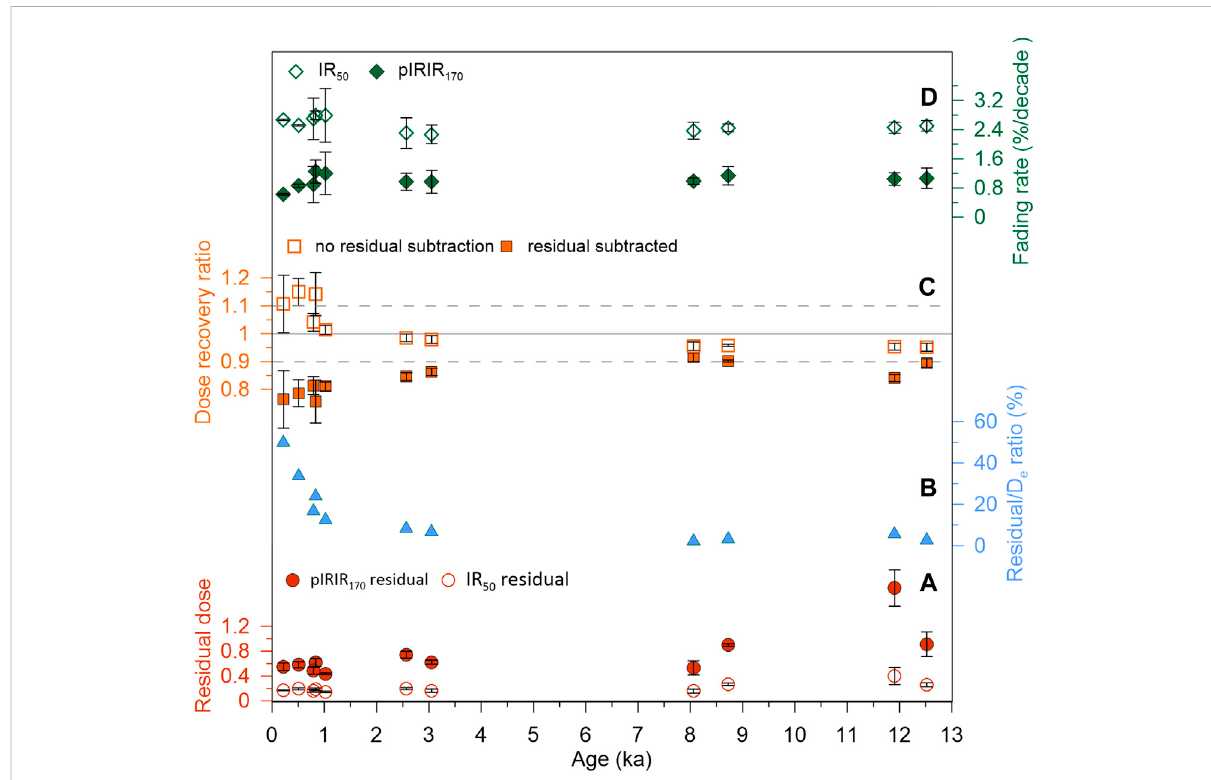
FIGURE 5 Residual dose, doserecovery ratio, andfading rate ofelevenselected samples withdifferentages. (A) Residual doseofpIRIR 170 andIR 50 signals; (B) residual to D e ratio of pIRIR 170 signal; (C) the results of dose recovery test, the fi lled circles show the residual subtracted dose recovery ratios, the open circles show the value without residual subtraction; and (D) fading rates of IR 50 and pIRIR 170 signals measured in the same pIRIR 170